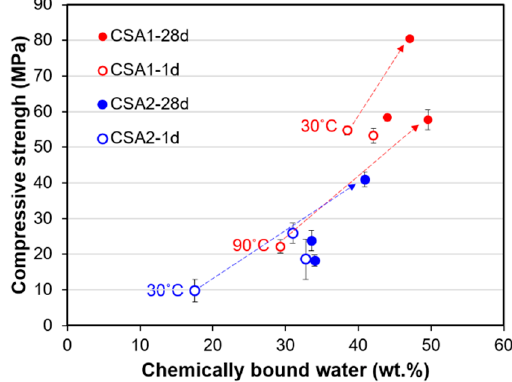
Figure 13. Inverse relationship between compressive strength measured at 1 day and 28 days and chemically bound water contents obtained by TGA on each samples cured at 1 day and 28 days. Grey arrows indicate the enhancement of strength from 1 day to 28 days and corresponding increase of chemically bound water contents from 1 day to 28 days.